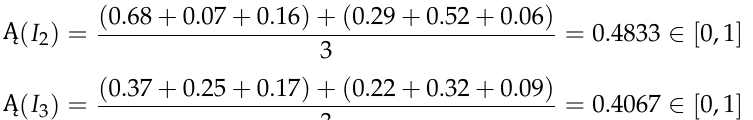
Table 1. Symbols and their meanings.